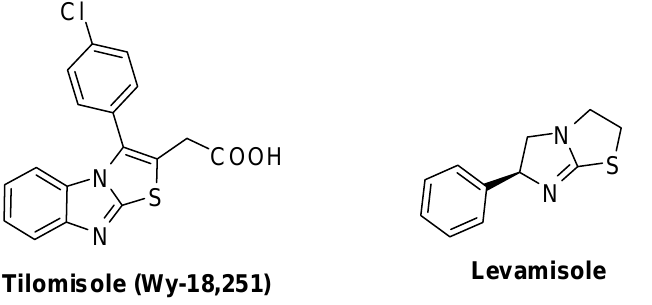
Figure 3. Chemical structure of tilomisole (WY-18,251) and levamisole.